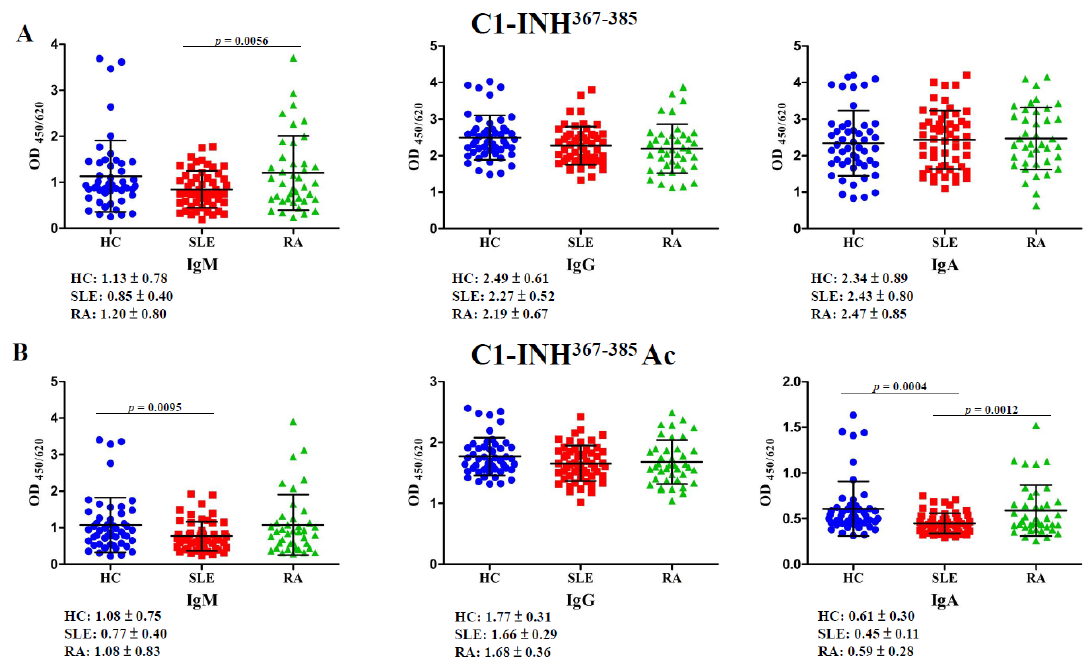
Figure 4. Dot plot of serum concentrations (absorbance units at 450/620 nm) of immunoglobulin M (IgM), IgG, and IgA autoantibody isotypes recognizing the C1-inhibitor (INH) 367–385 ( A ) and C1-INH 367–385 acetylation (Ac) ( B ) in 50 healthy controls (HCs), 54 patients with systemic lupus erythematosus (SLE), and 40 patients with rheumatoid arthritis (RA); the plot was obtained using an enzyme-linked immunosorbent assay (ELISA). OD 450/620 , optical density at 450/620 nm. Table 1. Associations of levels of the C1-inhibitor (INH), acetylation (Ac)-protein adduct, and anti-C1-INH 367–385 and anti-C1-INH 367–385 Ac peptide autoantibody isotypes with risks of SLE development in 54 patients with systemic lupus erythematosus (SLE) versus 50 healthy controls (HCs). HC SLE Univariate Logistic Regression Model a Age-Adjusted Logistic Regression Risk Factors Cut-o ff